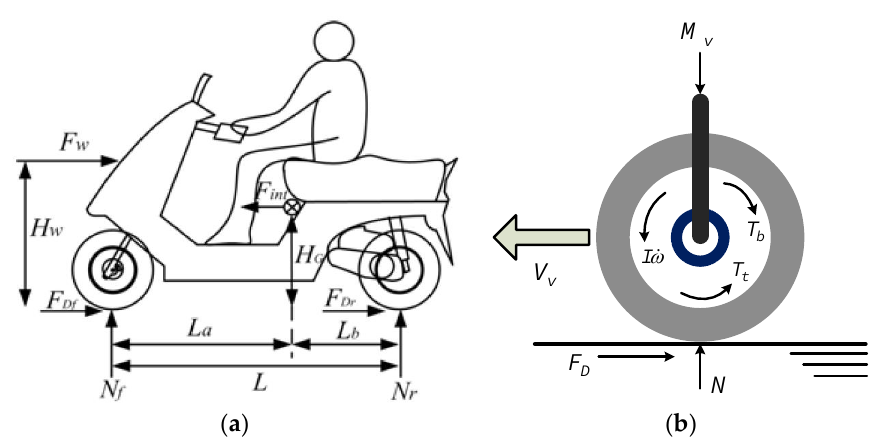
Figure 7. A simplified motorcycle structure: ( a ) motion model; and ( b ) single wheel braking model.